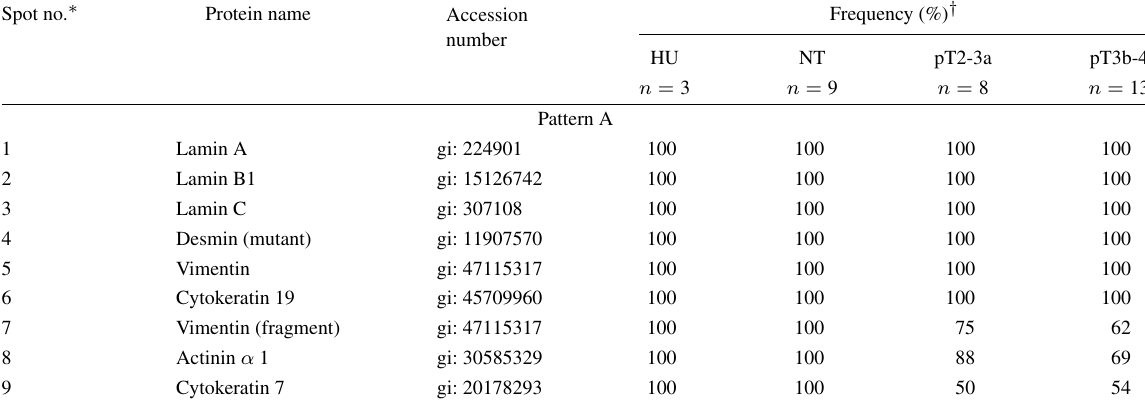
Frequency of expression of identified proteins in normal, non tumoral and tumoral tissues at different